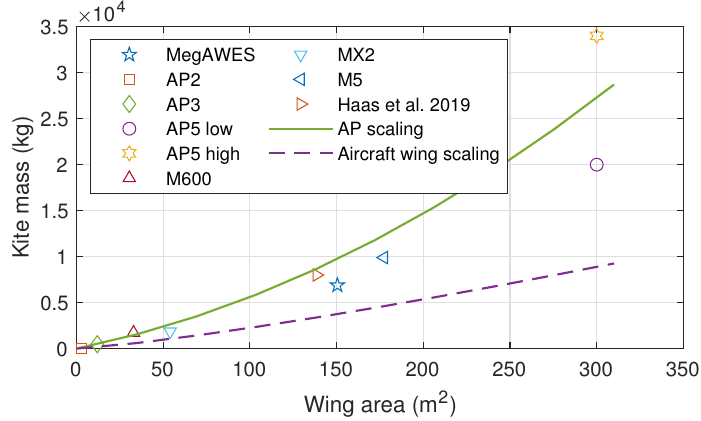
Figure 3. Masses of AWE systems as a function of the wing surface area. MegAWES [25], Ampyx Power AP2 and AP3 [20], AP5 low and AP5 high [26], Makani Power M600, MX2 (Oktoberkite), and M5 [27,28], Haas et al. 2019 [29], and conventional aircraft wing scaling